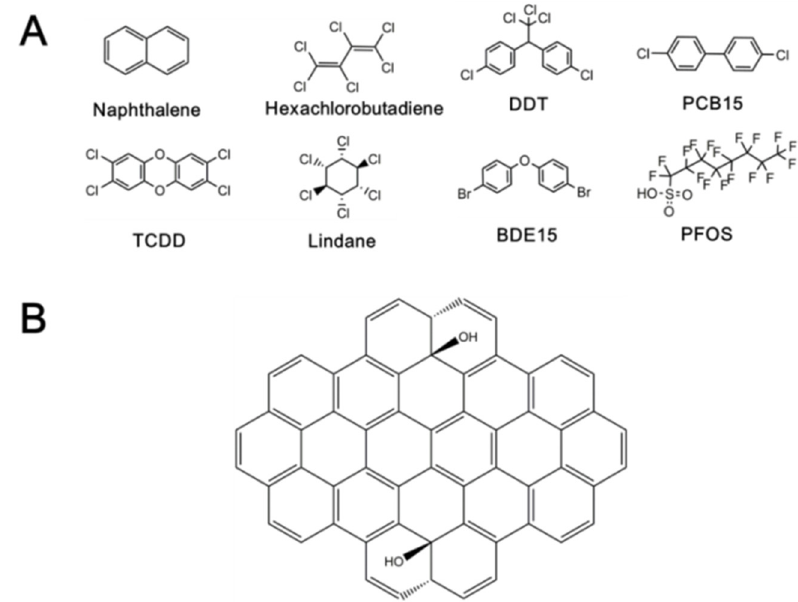
Figure 1. The structure of studied chemicals ( A ) and the proxy of GO ( B ). Table 2. The information about studied chemicals.